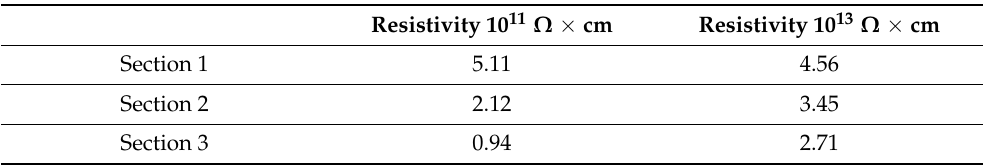
Table 9. Space charge density ( µ C/m 3 ) for rectified voltage, dust-free on collection surfaces, and two levels of dust resistivity